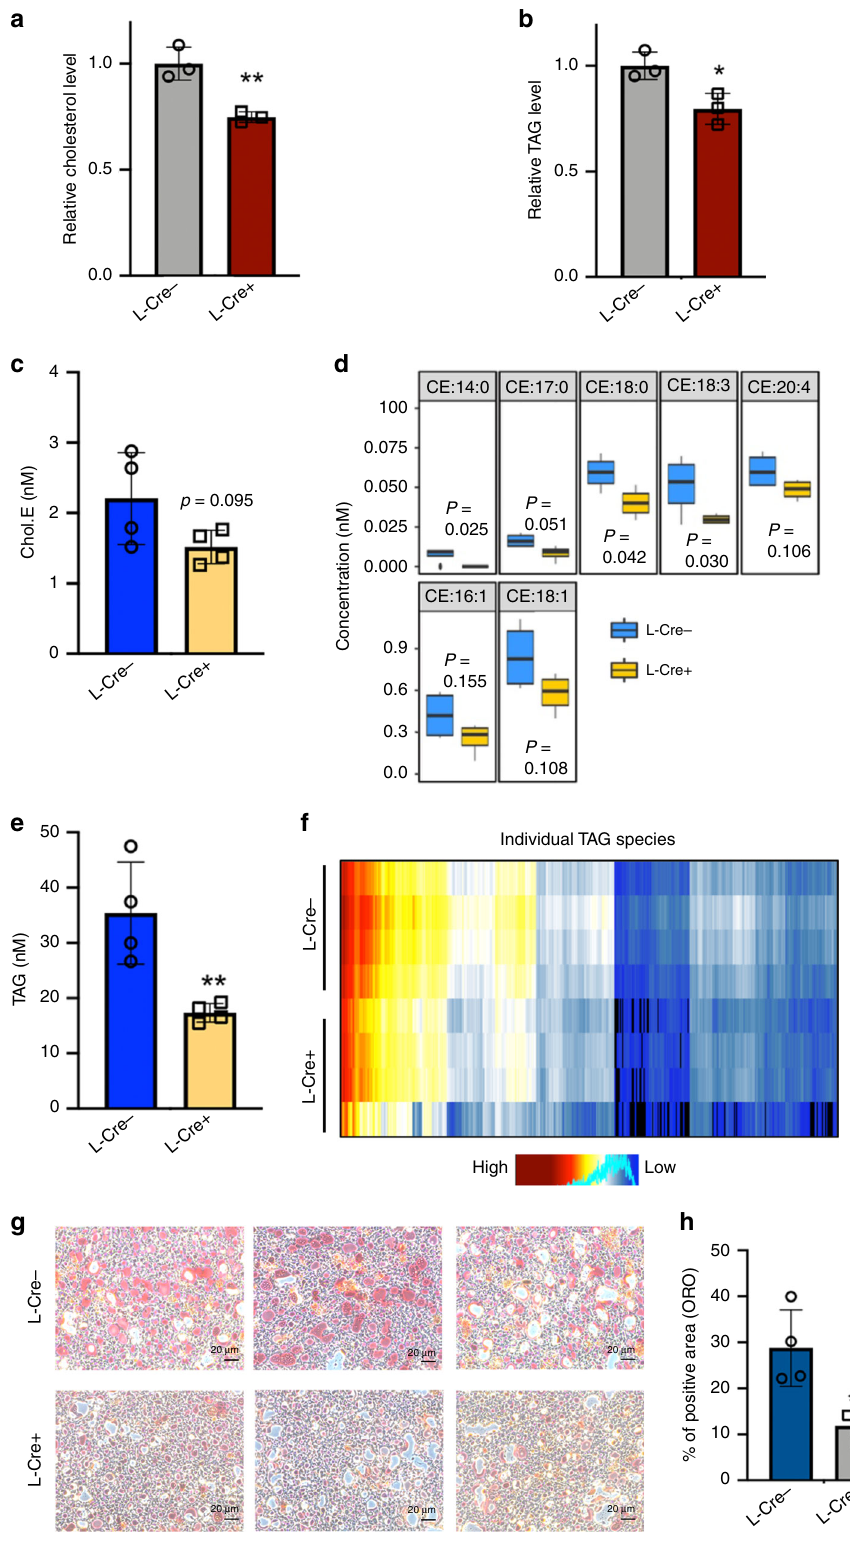
Fig. 2 Liver-speci fi c deletion of RALY alters hepatic lipid content. a , b Cholesterol level a and triglycerides level b from primary hepatocytes relative to baseline levels (normalized to cell number). c , d Lipidomics investigation of cholesterol ester (CE) species from liver from L-Raly knockout mice and controls ( n = 4 per group). e , f Lipidomics investigation of triglycerides species from liver from L-Raly knockout mice and controls ( n = 4 per group). Each line on heat map represents an individual triglyceride species of 411 different triglycerides detected (four mice per group). g Oil Red O (ORO) staining of liver from NASH diet-fed mice (scale bar, 20 µ m). h Quanti fi cation of positive ORO staining area from done with automated image j detection. Values are shown as means ± SD. * P < 0.05 and ** P < 0.01, using two-tailed Student ’ s t